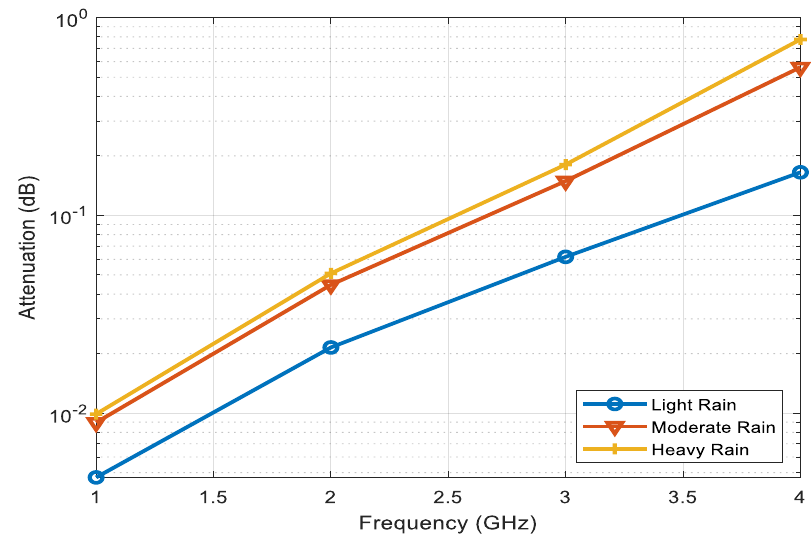
Figure 6. Rain attenuation plot versus frequency based on rainfall depth